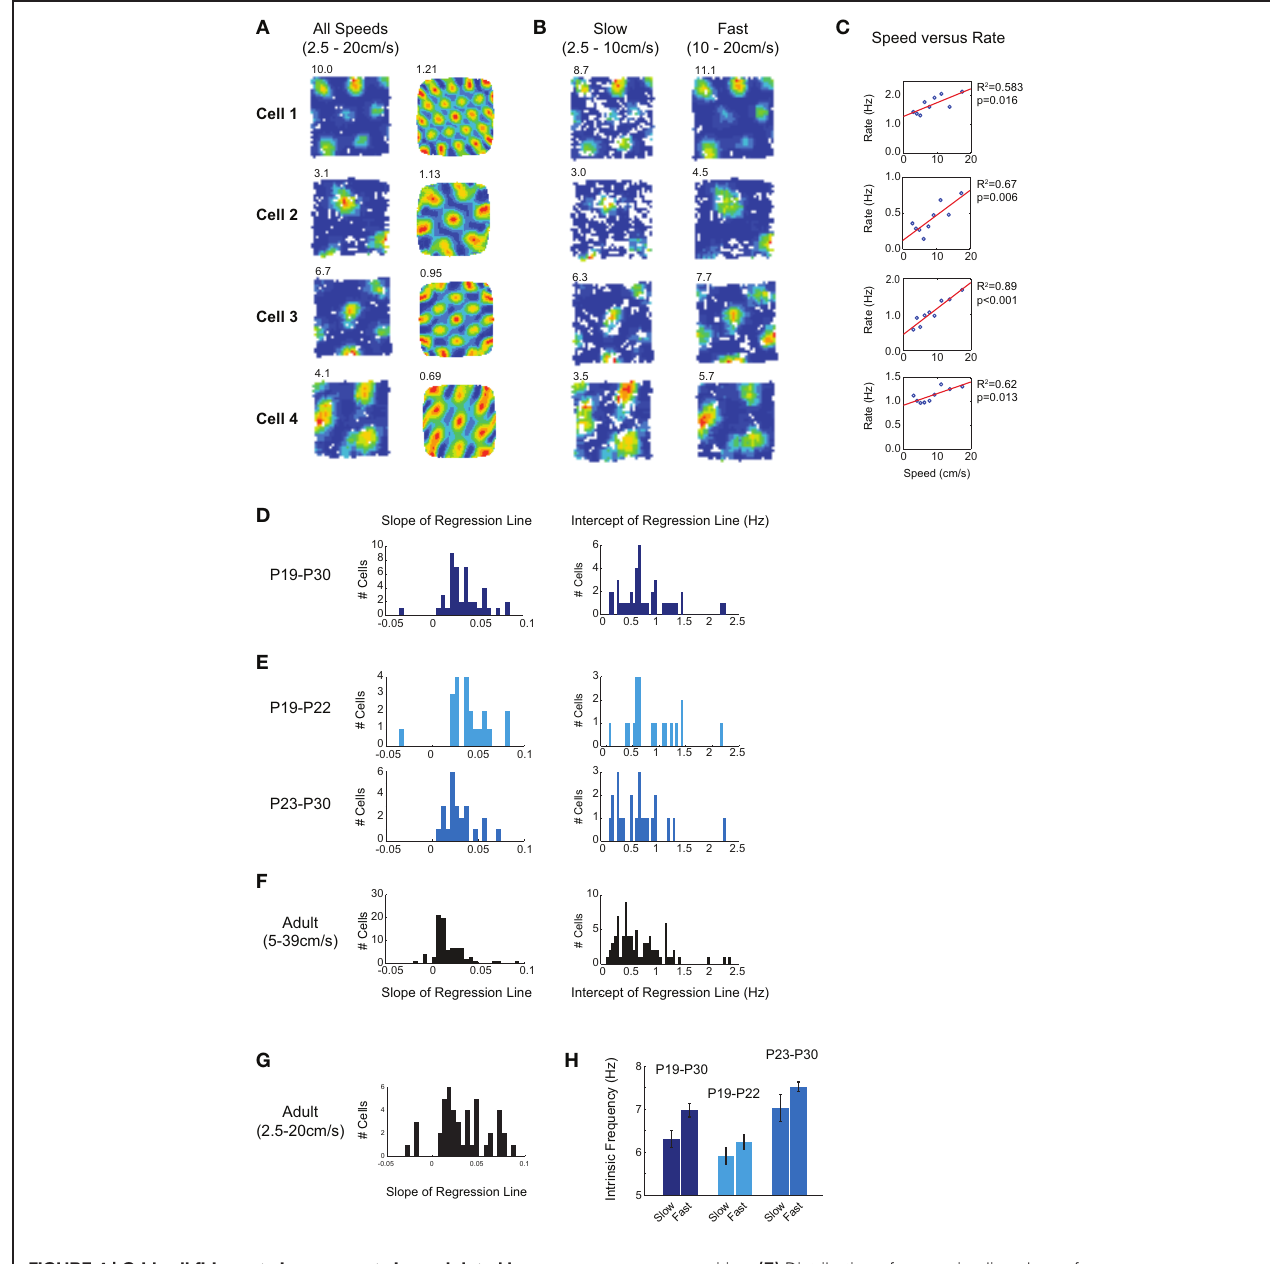
FIGURE 4 | Grid cell firing rate in young rats is modulated by running speed. (A) Firing rate maps and autocorrelograms for four grid cells. Peak firing rate is top left of rate map, gridness score is top left of autocorrelogram. Firing rate maps are constructed from data in which the running speed was 2.5–20cm/s. (B) Firing rate maps for the same four cells, with data filtered by either slow (2.5–10cm/s; left column) or fast (10–20cm/s; right column) running speeds. The grid firing field is preserved at both fast and slow speeds, but firing rates increase with running speed. (C) Scatter plots of mean firing rate versus running speed for the same four grid cells. The mean rates shown include both in- and out- of field firing. The red lines show linear regression fits to the speed versus firing rate data: R 2 and p values for these fits are shown to the right of the plots. (D) Distribution of regression line slopes and intercepts for all grid cells with a significant linear fit between speed and firing rate. Most cells increase firing rate with running speed, and all intercept values